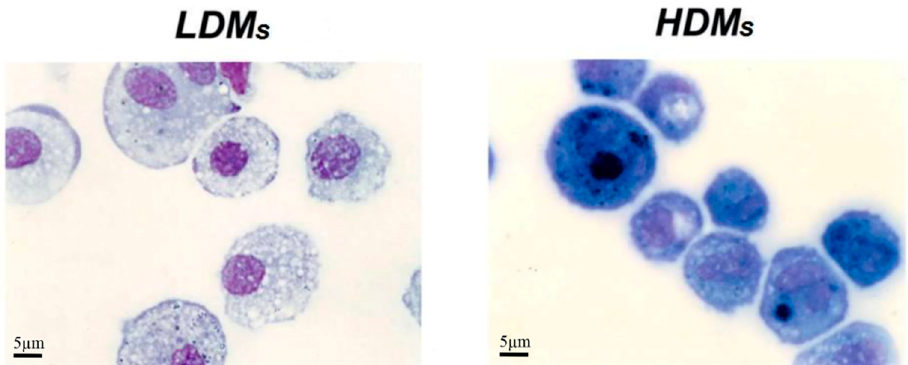
Figure 3. Cytocentrifuge preparation of HDMs and LDMs isolated by density gradient and adherence. Cell were stained with Diff Quick and analyzed by light microscopy. LDMs have round nuclei and an extended cytoplasm that stains poorly and is largely occupied by vacuoles. HDMs mostly comprise smaller cells with horse-shoe shaped nuclei; the cytoplasm is strongly basophilic and sometimes exhibits a juxtanuclear Golgi